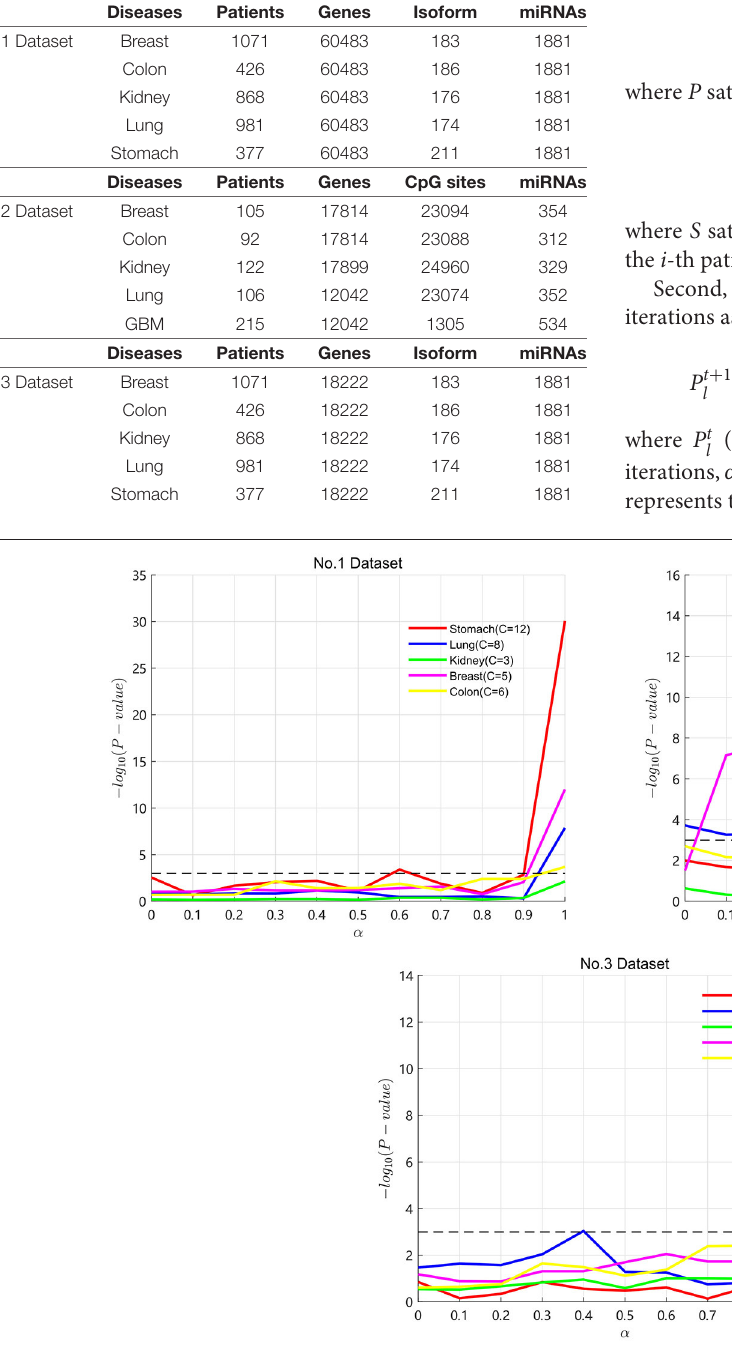
FIGURE 2 | Results of SKF with α on three